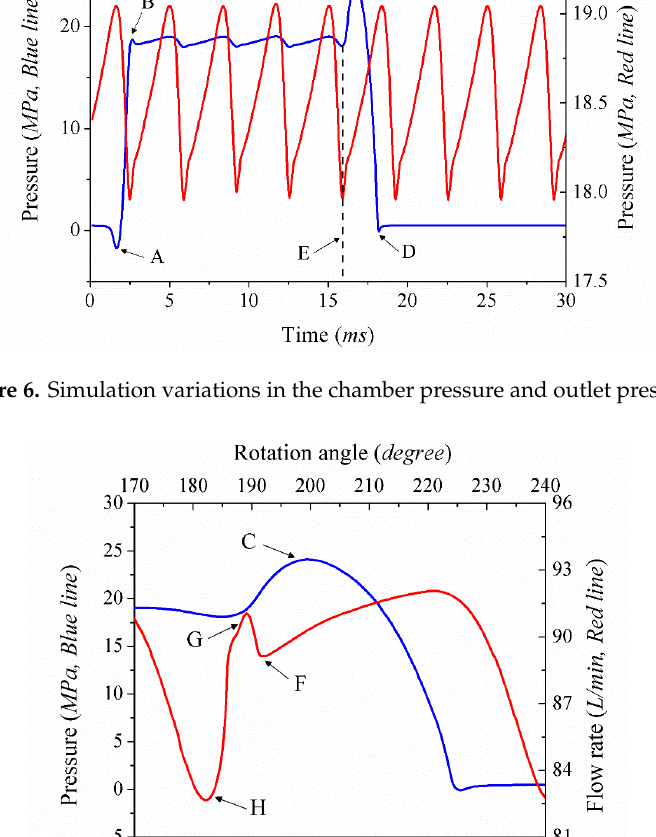
Figure 6. Simulation variations in the chamber pressure and outlet pressure.